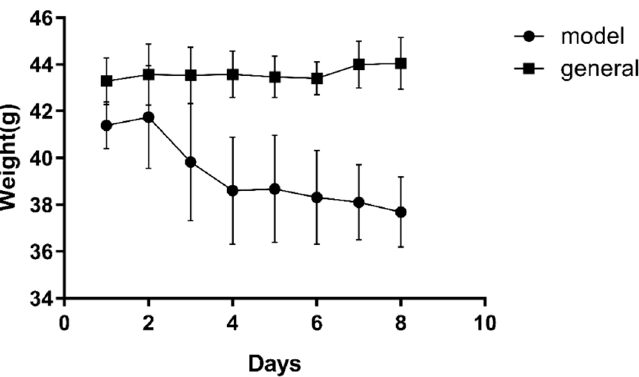
Figure 8. Body weight changes during the modeling. Note: the data were expressed as the mean ± the SD ( n = 9).